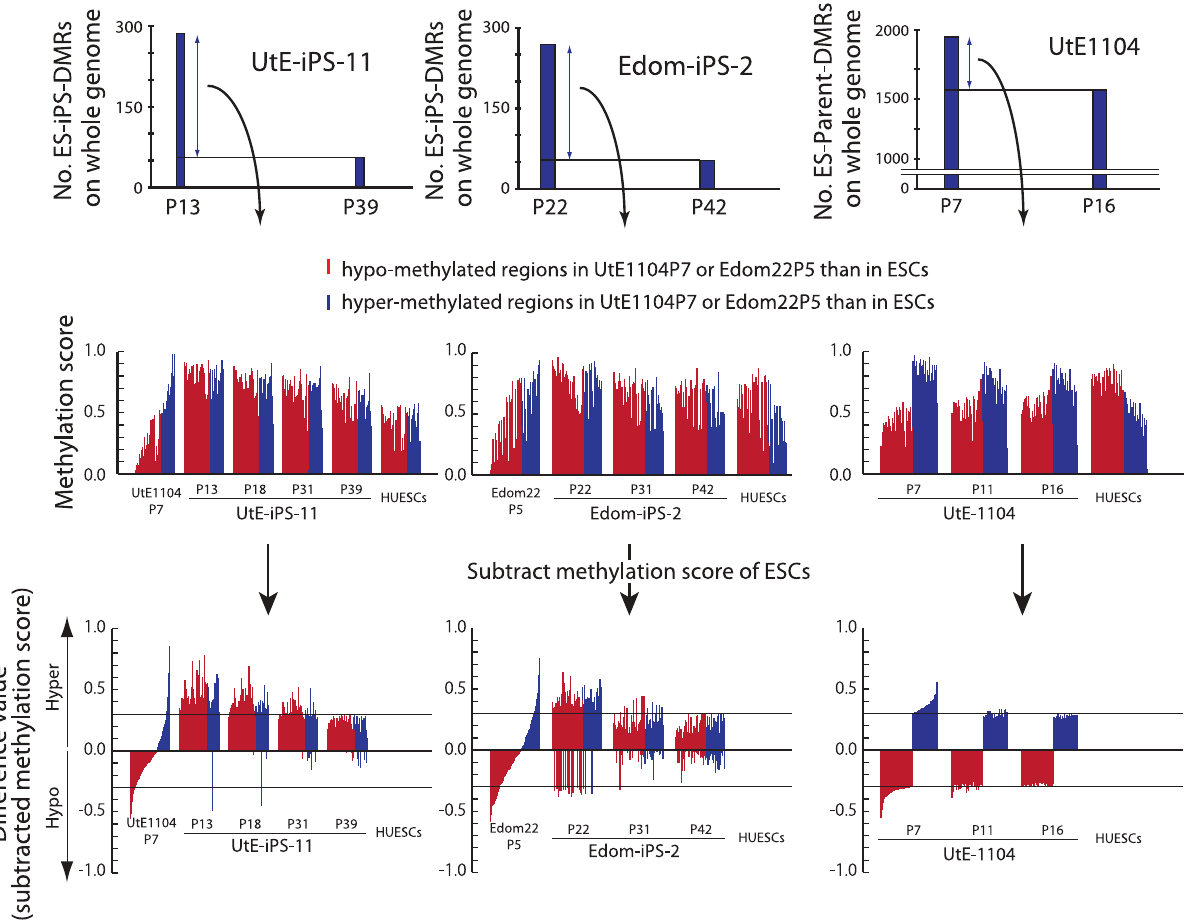
Figure 6. Hyper-methylation in the ES-iPS-DMRs and ES-parent-DMRs. ES-iPS-DMRs that disappeared in UtE-iPS-11 and Edom-iPS-2 at the latest passage (upper) were analyzed and the methylation score of each ES-iPS-DMR was plotted on bar graph (middle). To clearly compare methylation scores, difference value were estimated by subtracting the scores of ESCs from that of each sample (lower). Red and blue bars represent hypo- and hyper-methylated regions, respectively, in the parent cells, compared with ESCs. Notably, almost all the regions, even though their difference values were hypo-methylated in the parent cells, became hyper-methylated in iPSCs at the early passage, and then their methylation levels were adjusted to the level of ESCs with passaging, i.e. subtracted methylation score became close to zero. This transiently-induced hyper-methylation was not detected in parent cells.